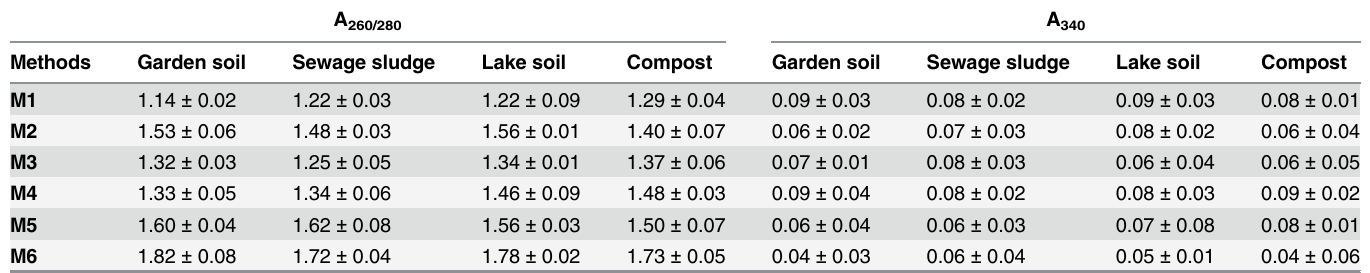
Table 4. Assessment of purity of metagenomic DNA by methods M1 to M6 for different